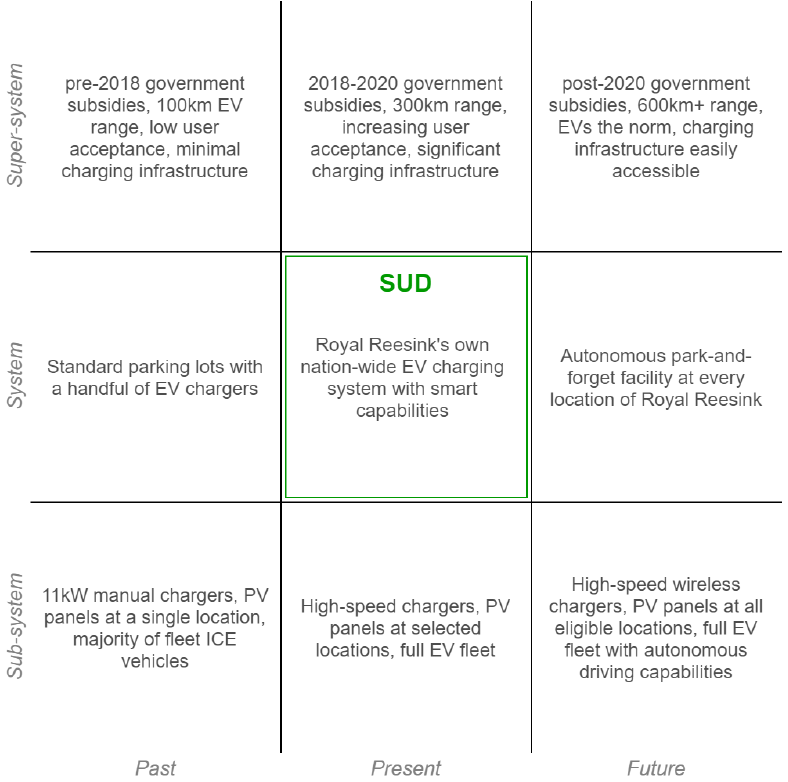
Figure 11. Nine-windows diagram placing the system in its temporal and hierarchical context, showing particular elements that affect the system and how they change over time. Developed from the model in